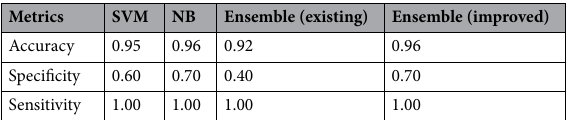
Table 6. Performance